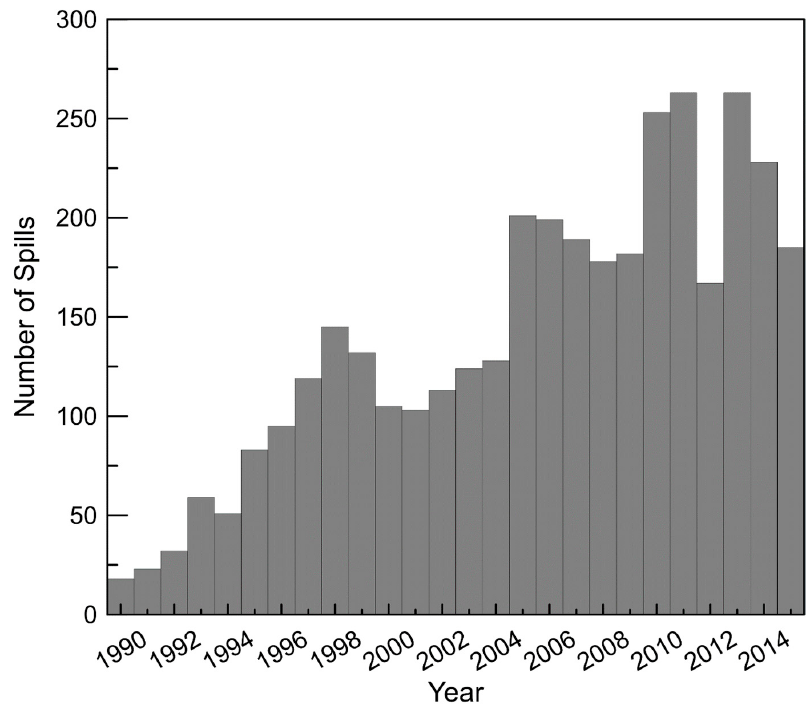
Figure 2. Number of produced water spills that occurred in Colorado from 1990 to 2015.